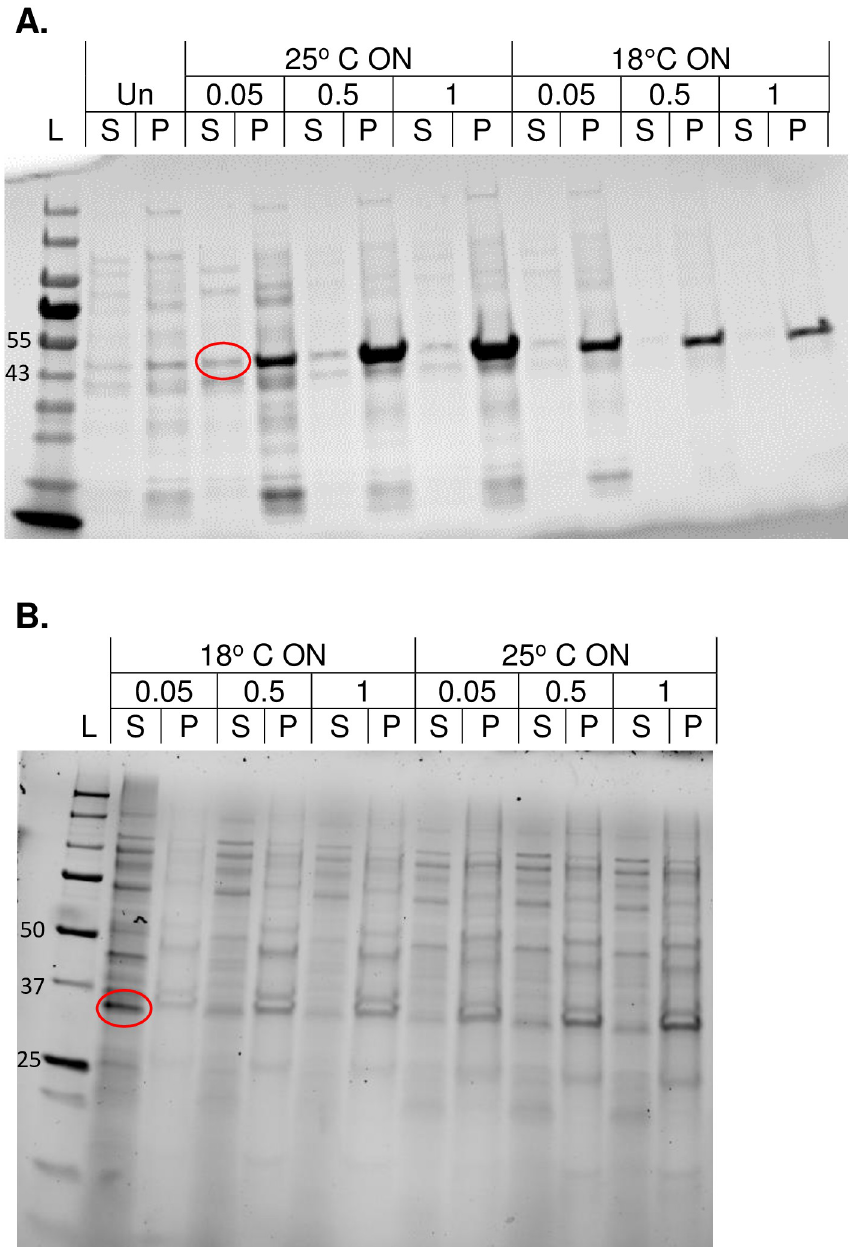
Fig 1. SDS-PAGE gels showing the effect of induction concentration and temperature on expression. A) EGFR-KD expression in BL21, and B) AurKA-KD expression in BL21 (DE3) pLysS strains with a similar trend of increasing soluble expression with lower IPTG concentrations and opposite expression trends with temperature of induction (Raw gels are shown in S1 Fig). L: Molecular weight ladder, Un: Uninduced sample, S: Supernatant and P: Pellet of cell lysates, ON: Overnight expression, and the numbers represent the concentrations of IPTG in mM. MKK3 showed a low expression level in most tested strains/conditions where expression under all tested conditions (S2 Table). Because of the low expression, it becomes difficult to visually determine the optimum conditions for expression across different SDS-PAGE gels;